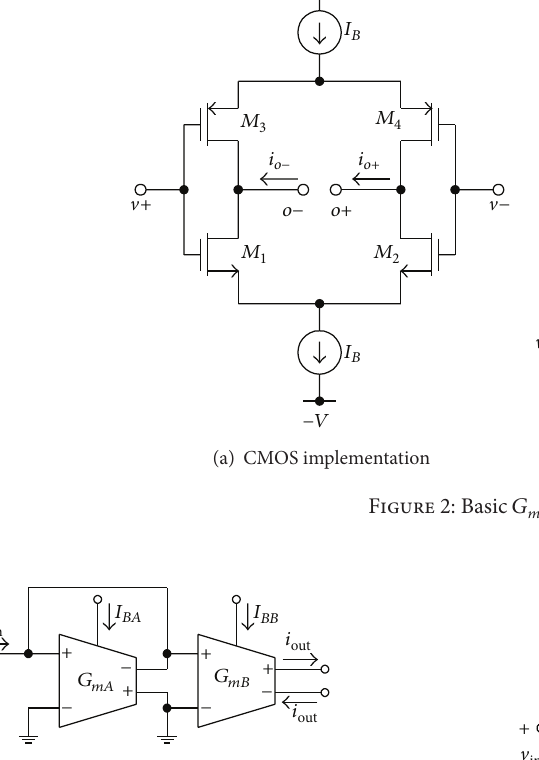
Figure 3: Current-controlled current amplifier (CCCA).